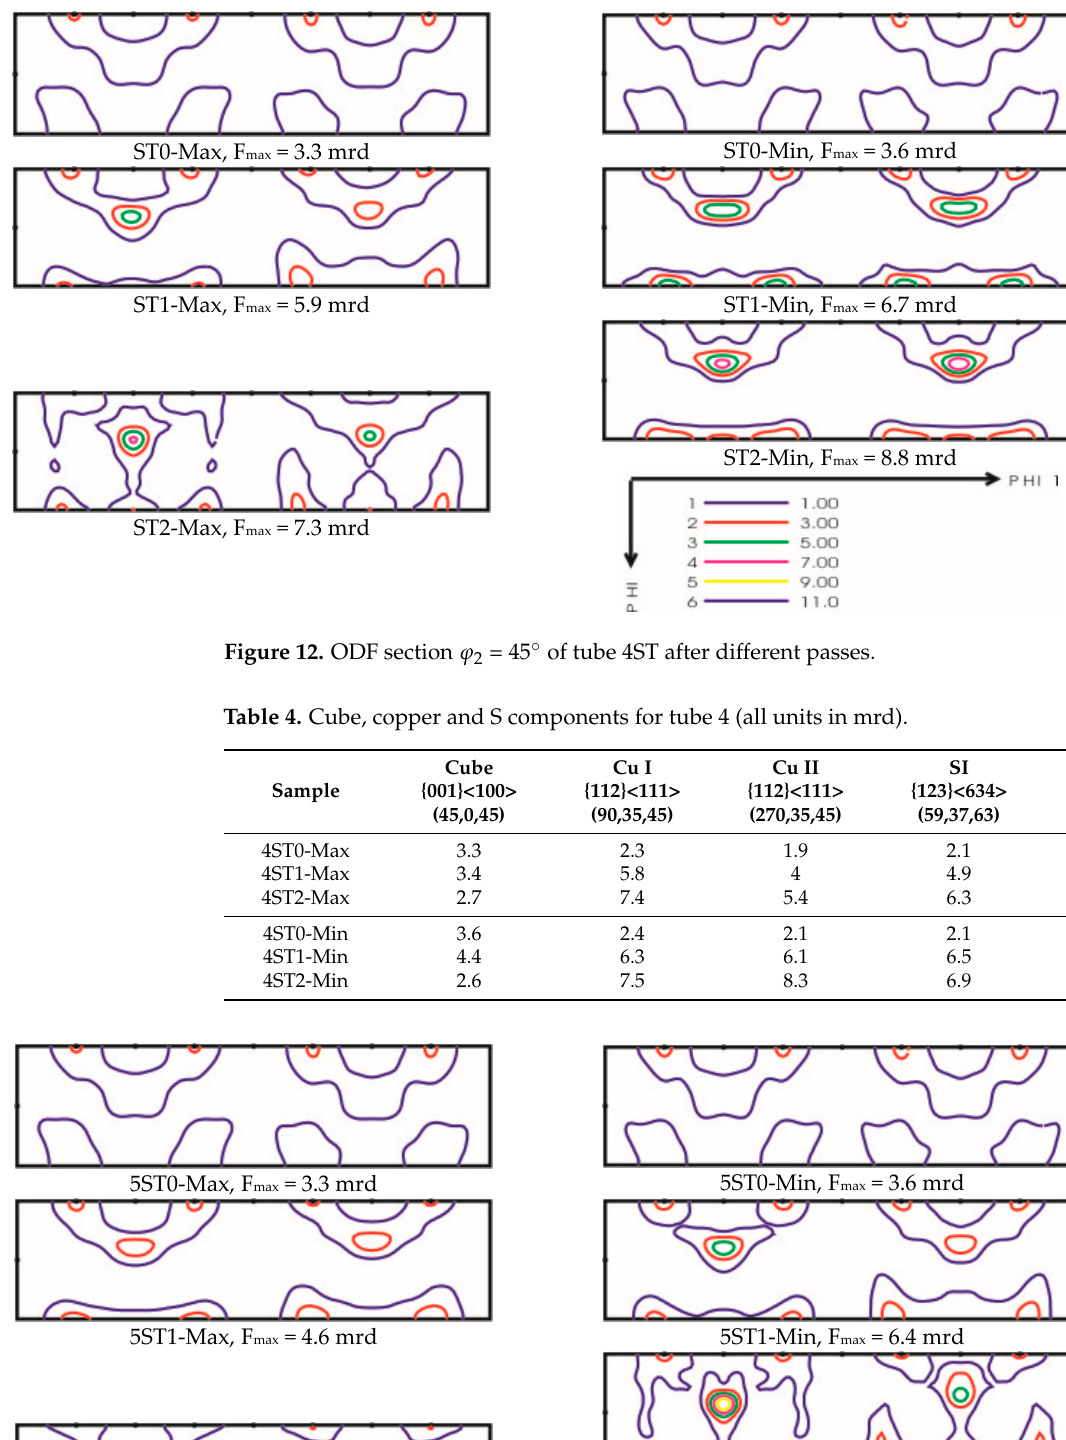
Figure 11. Texture components/fibers and their positions in the orientation space using triclinic sample symmetry for the orientation distribution function (ODF) sections ( φ 2 = 45°) for the copper tube. When comparing only the cube component in φ 2 = 45° (Figure 12), no variation be- tween φ 1 = 45°, φ 1 = 135°, φ 1 = 225° and φ 1 = 315° is visible, which means the grains with cube component follow the orthorhombic sample symmetry. The copper and S compo- nents show the expected monoclinic sample symmetry (see also Tables 4 and 5).